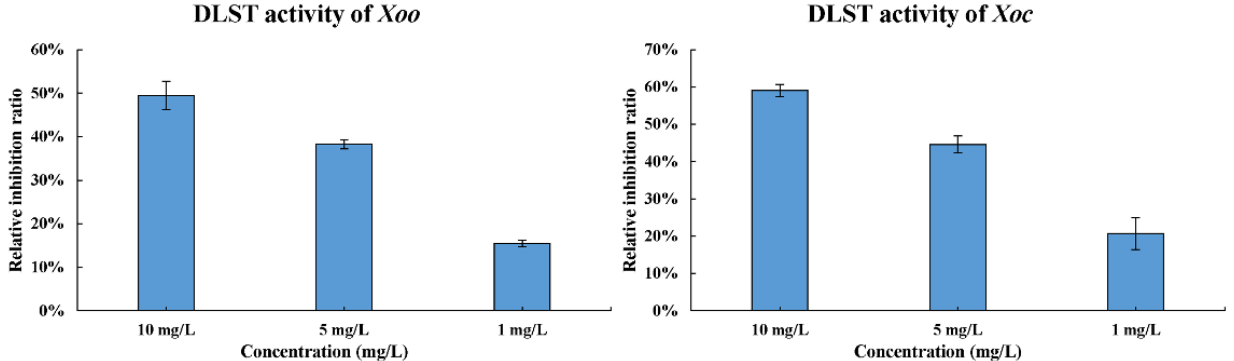
Figure 5. DLST activity of Xoo and Xoc at 10, 5, and 1